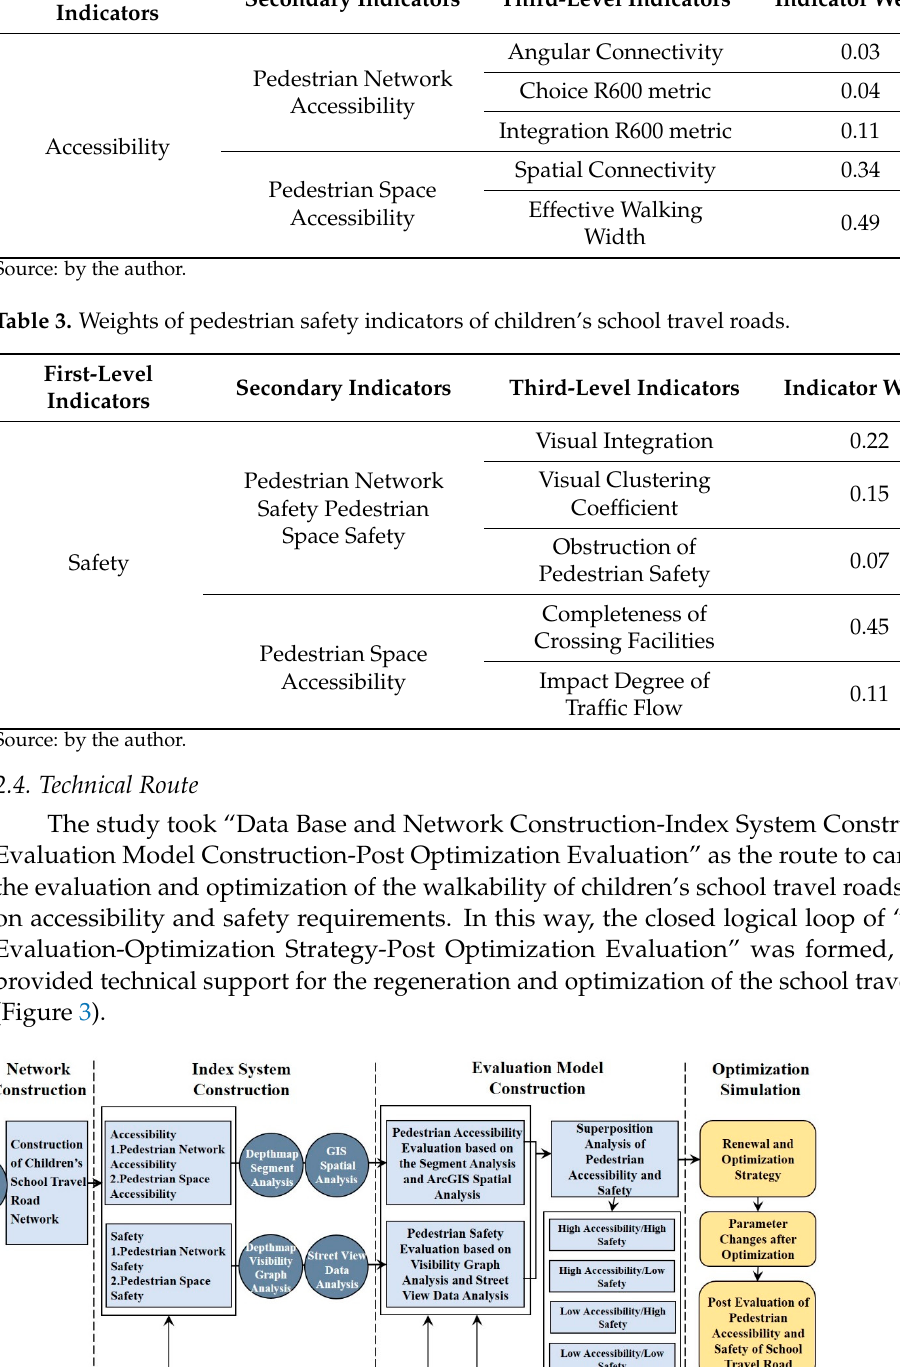
Figure 3. Technical